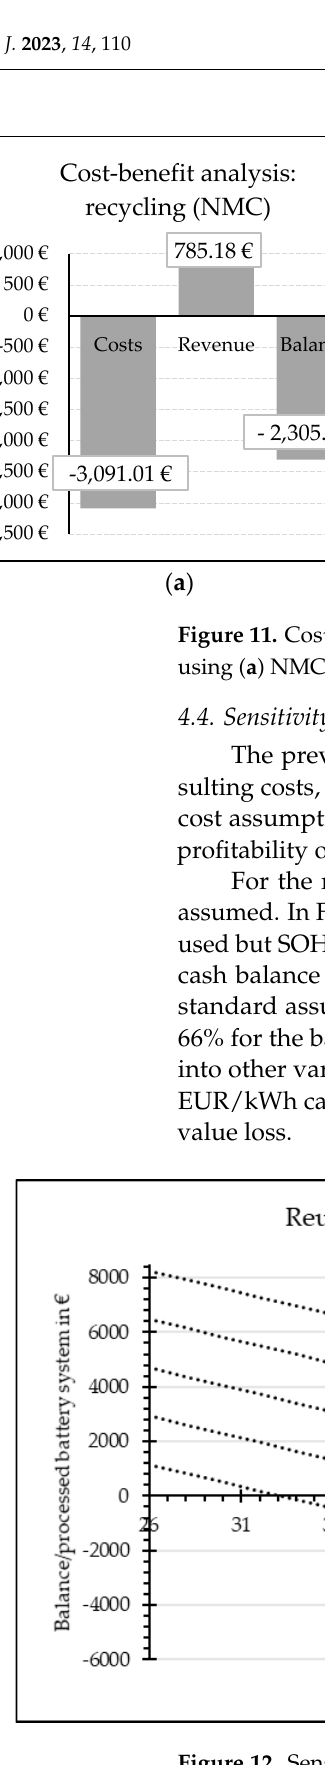
Figure 12. Sensitivity analysis: influence of the value loss in relation to the purchase price on the cost – benefit balance.